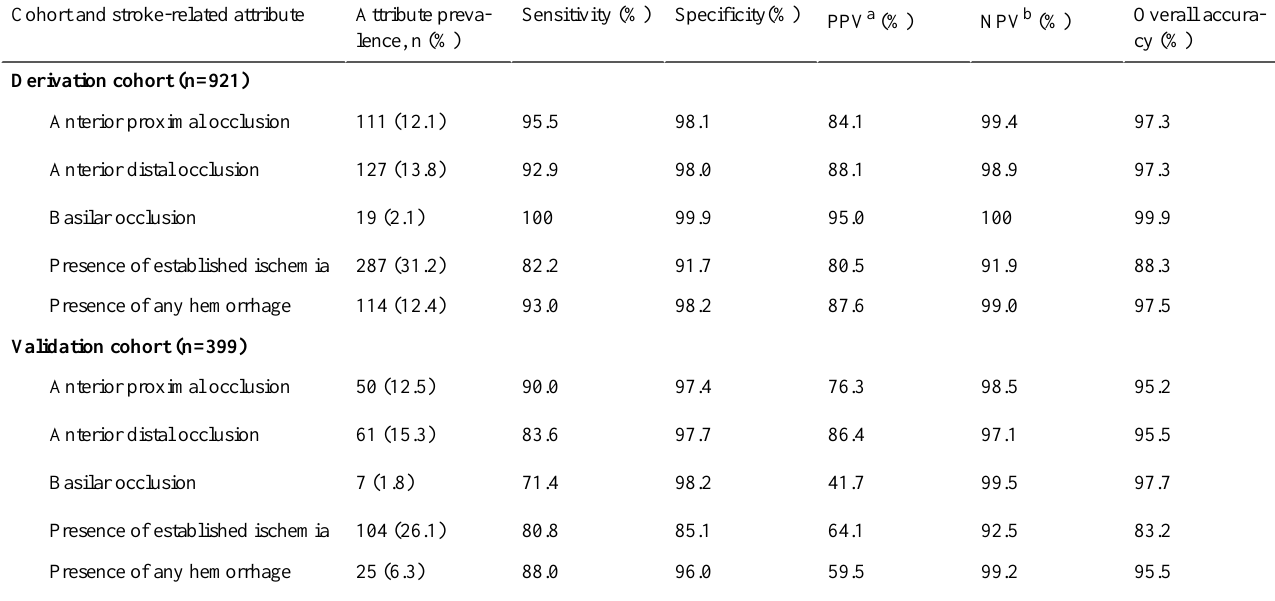
Table 1. Accuracy of the natural language processing tool CHARTextract to identify stroke-related attributes in diagnostic imaging reports.